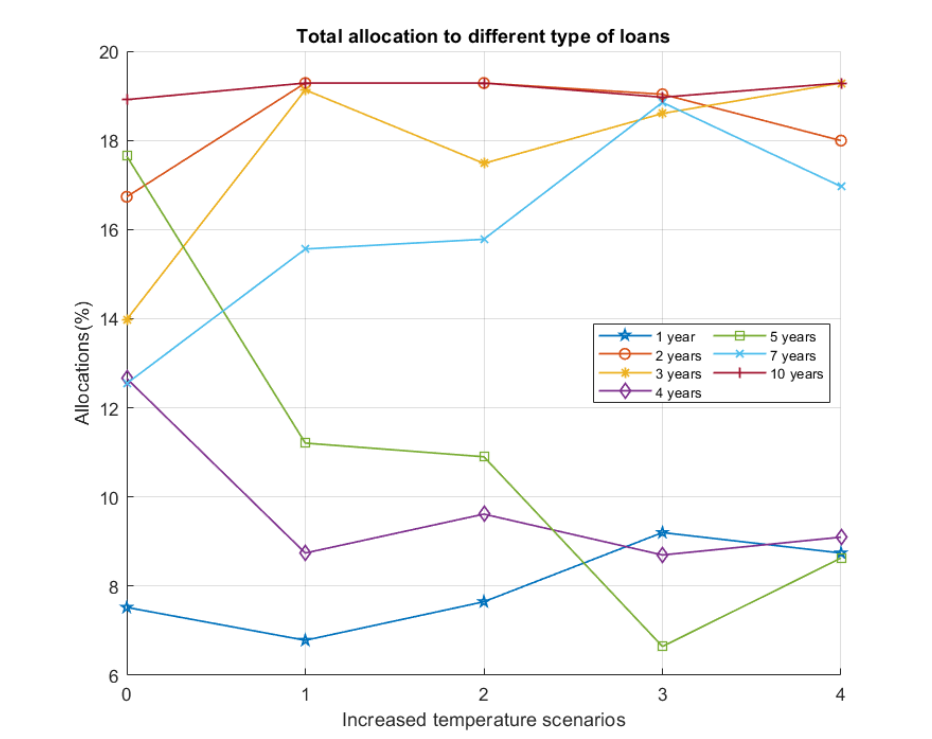
Figure 9. Allocations to each tenor of loan under five different 1 ◦ C increased temperature